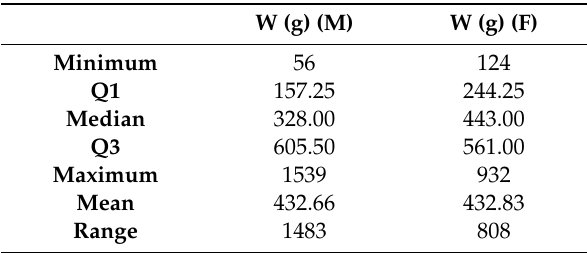
Table A3. Minimum, median, average and maximum values of W regarding the spiny lobsters’ measurements, from the Thermaikos Gulf,